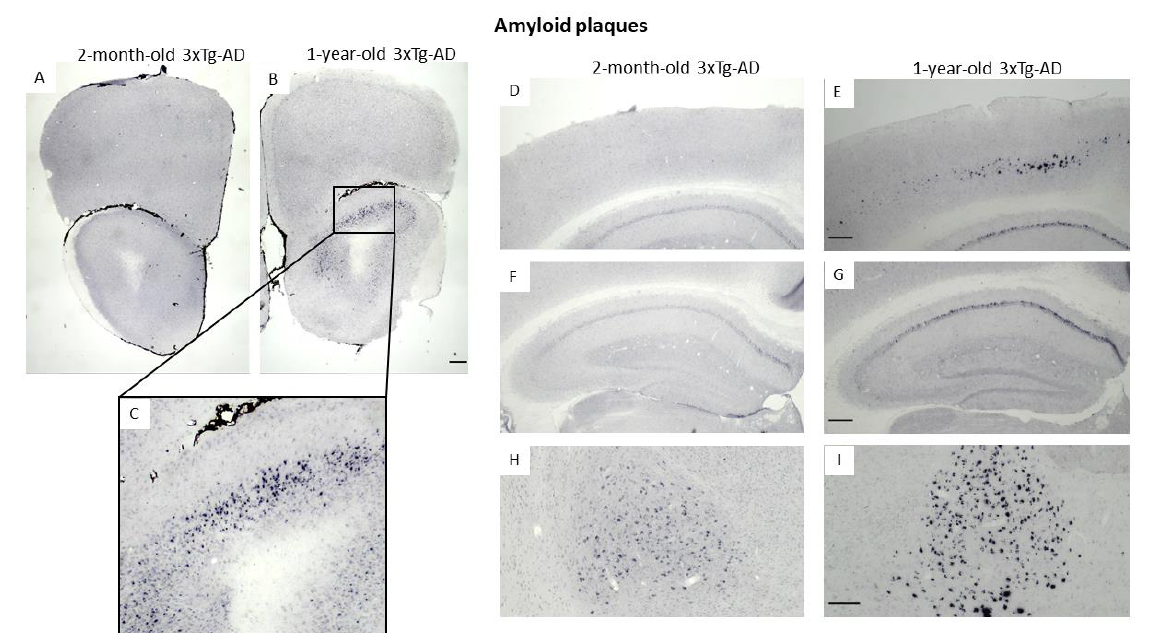
Figure 6. Amyloid- β 1 – 42 plaques stained with Ni-DAB immunohistochemistry in 2-month-old and 1-year-old 3xTg-AD mice. The images show different brain areas: the olfactory bulb ( A – C ), motor- and somatosensory-cortex, ( D , E ), hippocampus ( F , G ), basolateral and basomedial amygdala ( H , I ). Scale bar in ( B , E , G ) is 200 µ m, and in ( I ) 100 µ m.